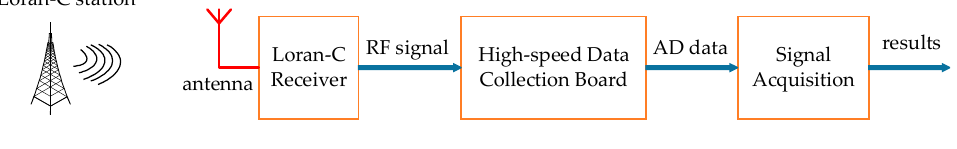
Figure 13. Test scheme of acquisition method.